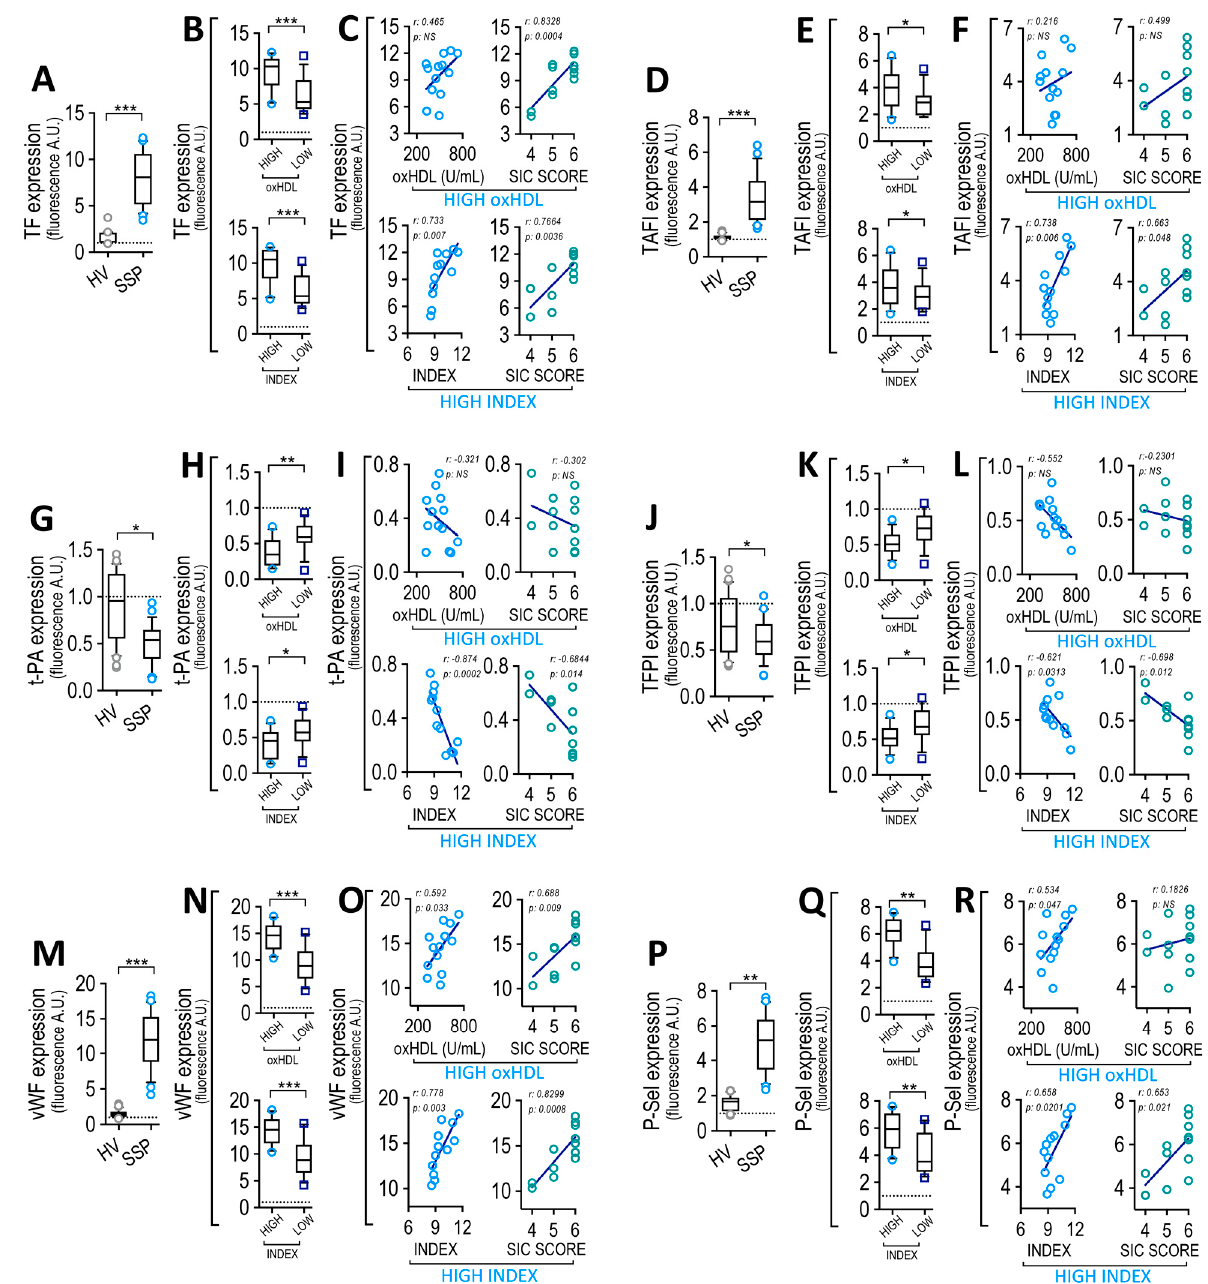
Figure 6. Coagulation factors and soluble platelet adhesion protein expression in CMEC from SSP. Normalized expression level of TF ( A ), TAFI ( D ), t-PA ( G ), TFPI ( J ), svWF ( M ) and sP-Sel ( P ) in HV and SSP. Plasma level of TF ( B ), TAFI ( E ), t-PA ( H ), TFPI ( K ), svWF ( N ) and sP-Sel ( Q ) in high- and low-oxHDL and high- and low-INDEX groups from SSP. Statistical differences were assessed with student's t-test (Mann–Whitney). * p < 0.05, ** p < 0.01, *** p < 0.001. Values are expressed as the median ± 10–90 percentile. Correlation analyses between: TP with high-oxHDL ( C , left panel, r = 0.465; p = 0.109), SIC score from high-oxHDL ( C , middle-left panel, r = 0.8328; p = 0.0004), high- INDEX ( C , middle-right panel, r = 0.733; p = 0.007) and SIC score from high-INDEX ( C , right panel, r = 0.7664; p = 0.0036), TAFI with high-oxHDL ( F , left panel, r = 0.2168; p = 0.477), SIC score from high-oxHDL ( F , middle-left panel, r = 0.499; p = 0.167), high-INDEX (F, middle-right panel, r = 0.738; p = 0.006) and SIC score from high-INDEX ( F , right panel, r = 0.663; p = 0.048), t-PA with high-oxHDL ( I , left panel, r = − 0.3213; p = 0.2845), SIC score from high-oxHDL ( I , middle-left panel, r = − 0.302; p = 0.3169), high-INDEX ( I , middle-right panel, r = − 0.8743; p = 0.0002) and SIC score from high-INDEX (I, right panel, r = − 0.6844; p = 0.03169), TFPI with high-oxHDL ( L , left panel, r = − 0.552; p = 0.0505), SIC score from high-oxHDL ( L , middle-left panel, r = − 0.2301; p = 0.4495), high-INDEX ( L , middle-